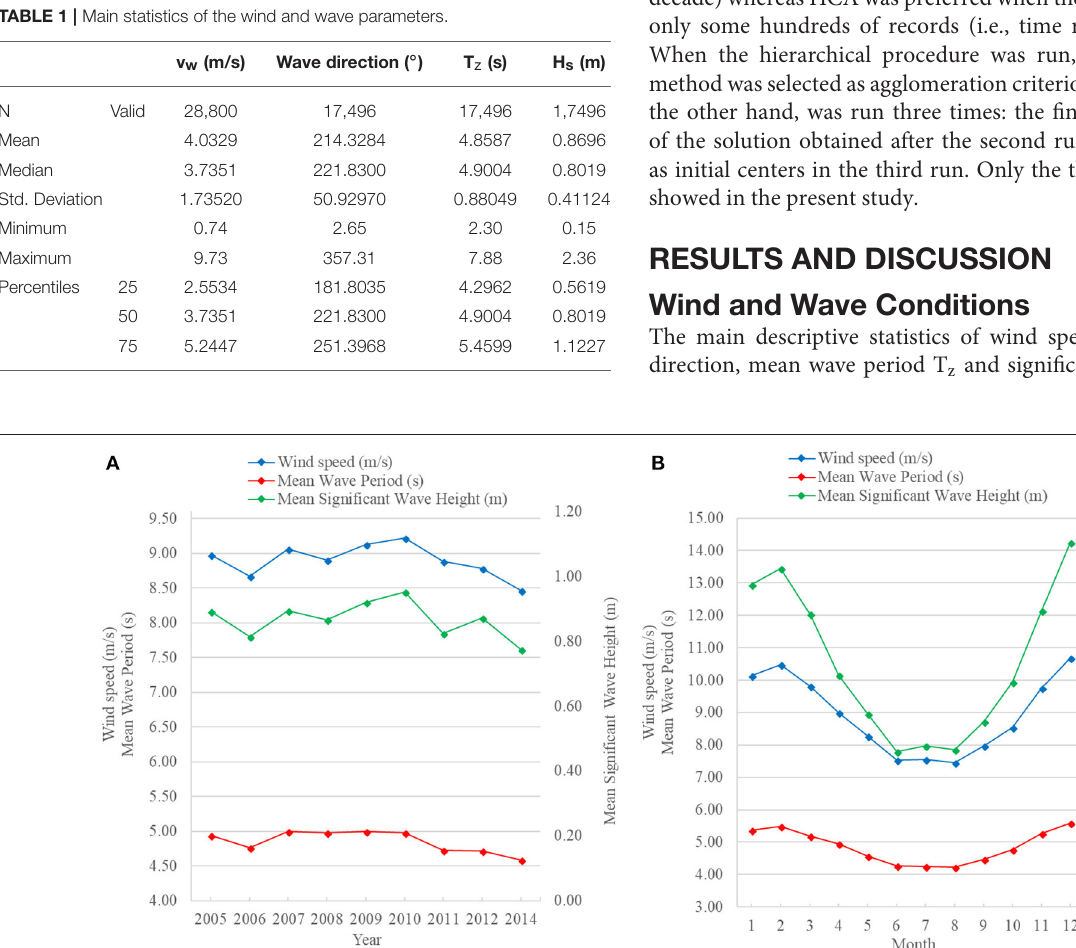
Frontiers in Energy Research |